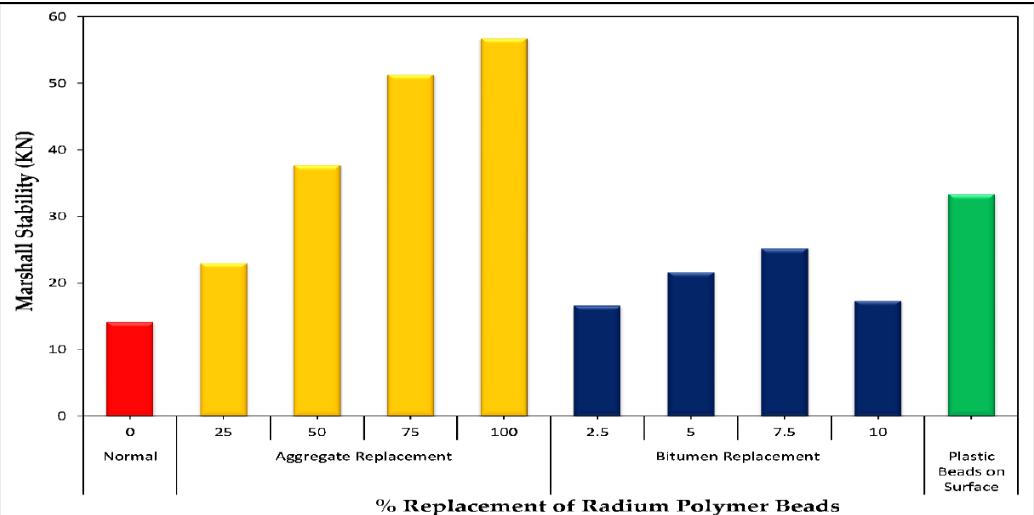
Figure 11. Marshall stability versus radium polymer materials (%).